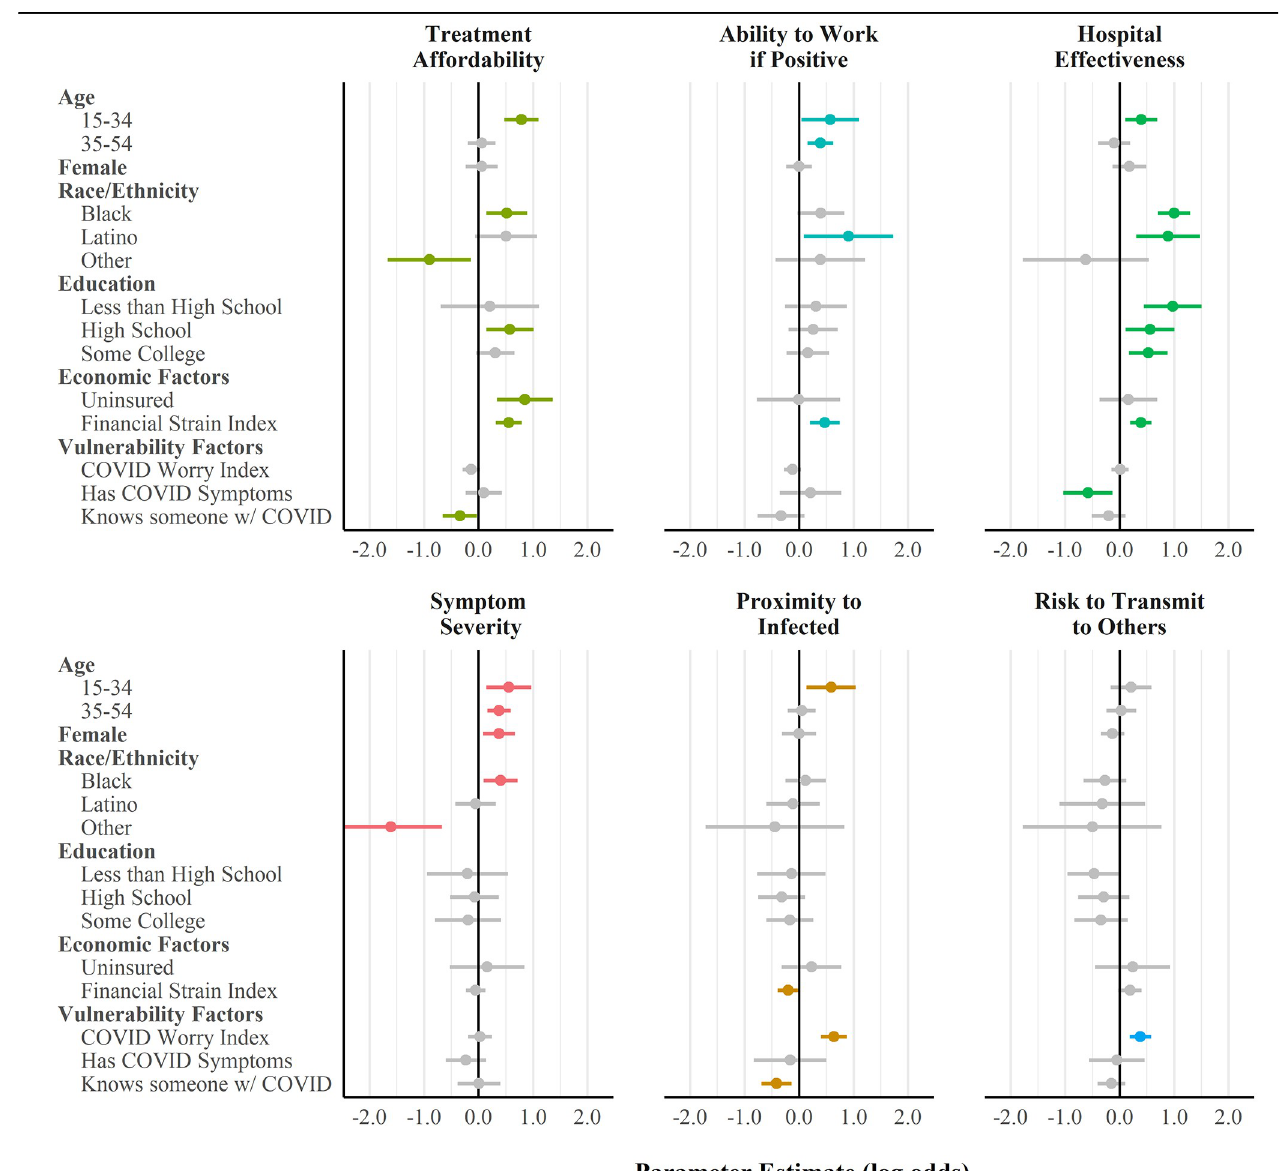
Fig 3. Multivariate regression results for the influence of sociodemographic, economic, and psychological determinants on testing intentions.